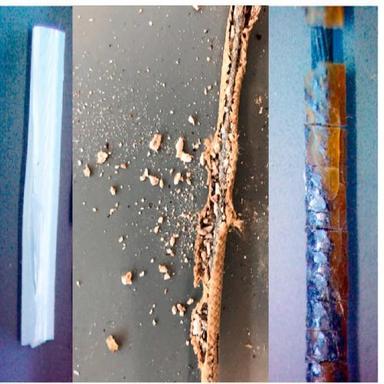
Baseline (left) and atmospheric (middle and right) silicone rubber insulations.